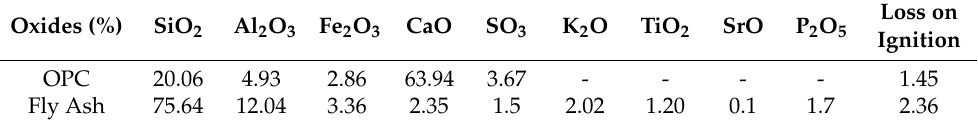
Table 1. Elemental compositions of the ordinary Portland cement (OPC) and fly